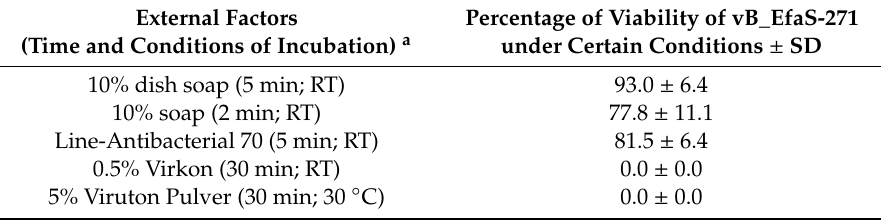
Figure 5. The lysis profile of host bacteria after infection of E. faecalis 271 (black squares and columns; Panels A – C ) and 272 (gray squares and columns; Panels D – F ) with the vB_EfaS-271 bacteriophage at an M.O.I. of 0.05. The results are presented as the bacterial culture density measured spectrophotometrically at OD 600 ( A ), the number of bacterial cells surviving the phage infection per 1 mL (CFU/mL) ( B ) and the number of phages per 1 mL (PFU/mL) ( C ). The results are shown as the mean values ± SD from three biological experiments. Note that in some cases the error bars are smaller than sizes of symbols. One-step growth experiments were performed only after infection of the E. faecalis 271 host, as development of the phage in the 272 strain was too slow to allow for precise determination of the measured parameters (compare Figure 5D–F). These experiments confirmed that vB_EfaS-271 develops rapidly in the 271 host cells at 37 °C. The eclipse time was as short as 2 min, and the latency period was estimated to be 8 min. The average burst size was approximately 70 progeny viruses per cell (Figure 6A). Adsorption of vB_EfaS-271 on cells of the E. faecalis 271 host was also very efficient. Over 90% of the virions were effectively adsorbed within 90 s of incubation (Figure 6B).